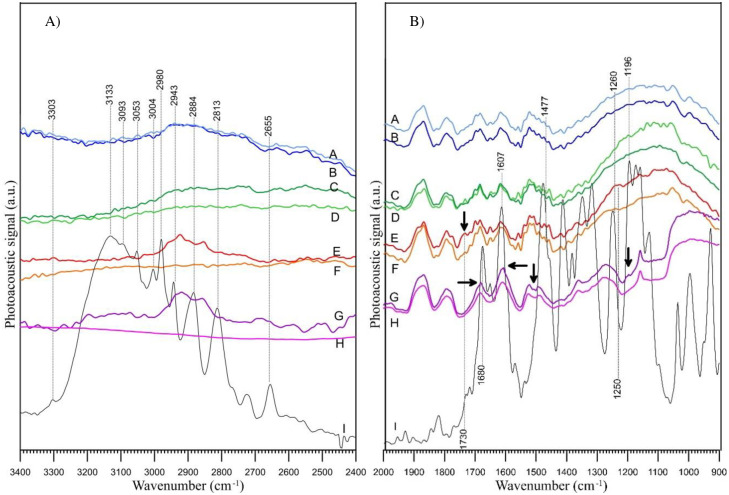
FT-IR/PAS spectra of examined samples of AR774C soil fraction < 500 μm: (A) within 3400–2400 cm–1, (B) within 2000–900 cm–1.The baselines are displaced vertically to avoid overlaping. The used designations denote: A–soil at pH 7.5, B–soil + bentazone at pH 7.5, C–soil at pH 5.2, D–soil + bentazone at pH 5.2, E–soil at pH 3.5, F–soil + bentazone at pH 3.5, G–soil at pH 1.6, H–soil + bentazone at pH 1.6, and I–pure bentazone.